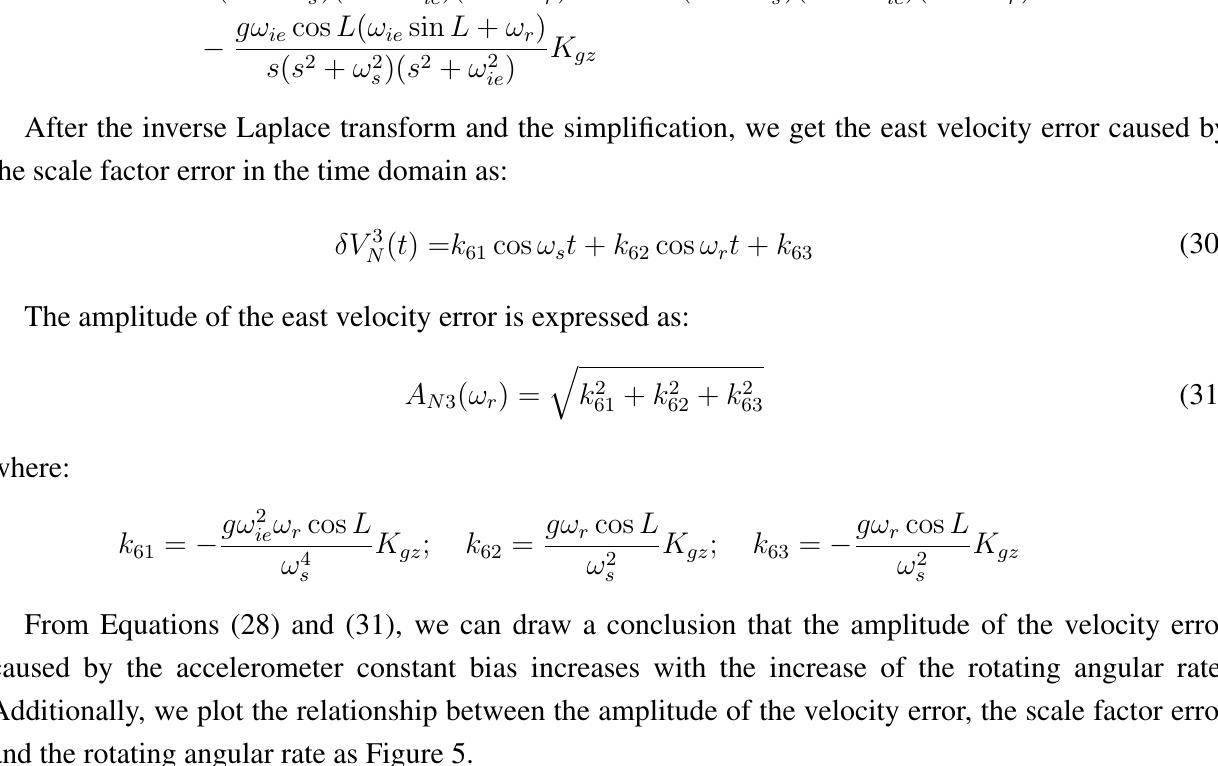
Figure 5. The relationship curve of the amplitude of the velocity error, the scale factor error and the rotating angular